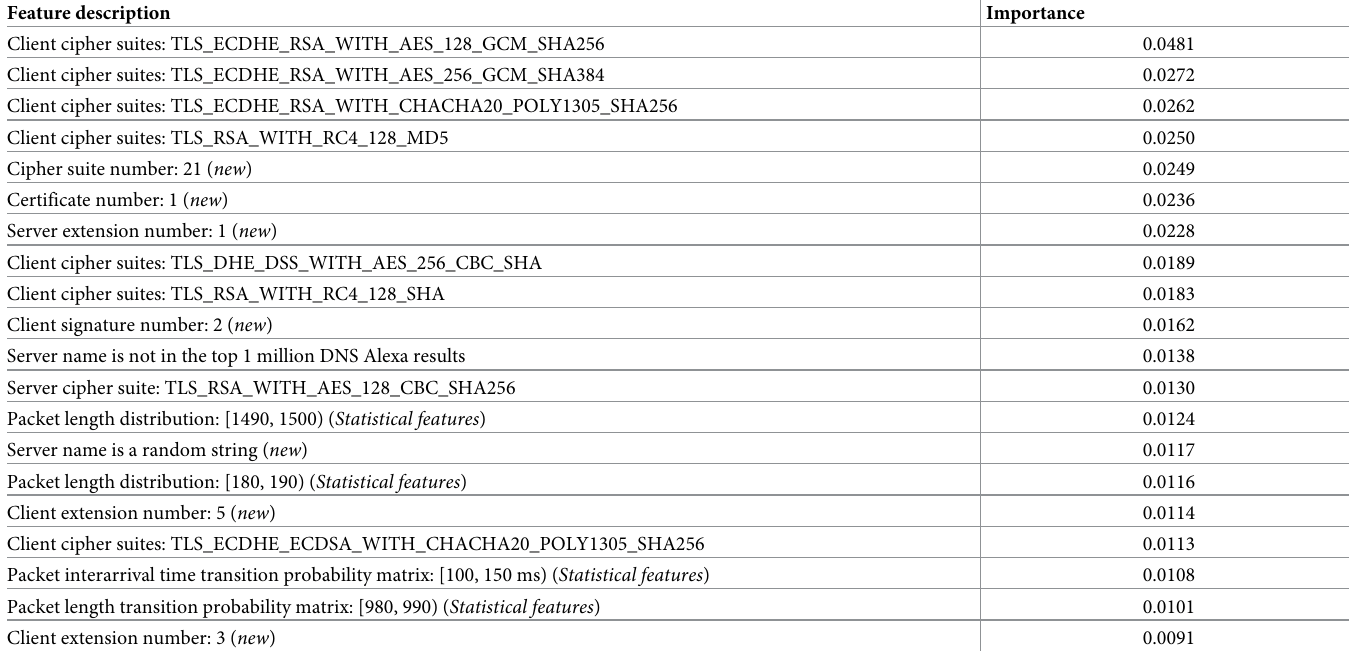
Table 7. The most important 20 features in the malware family classification